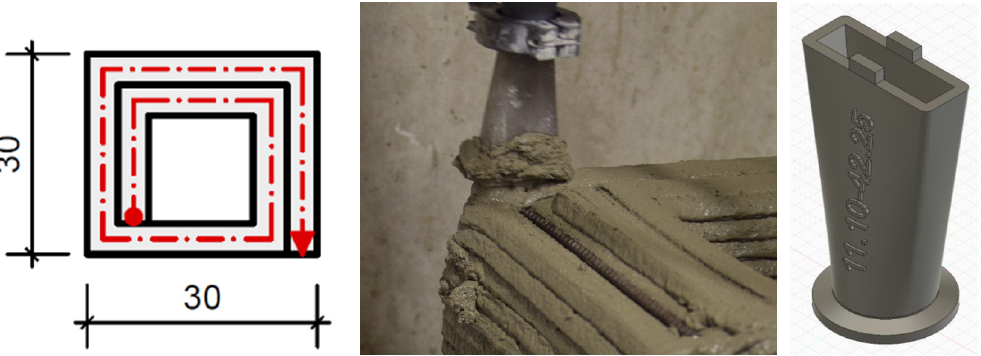
Figure 2. Sample geometriy ( left ), deposition of a layer on top of horizontal reinforcement ( middle ) and nozzle with tongue ( right ).